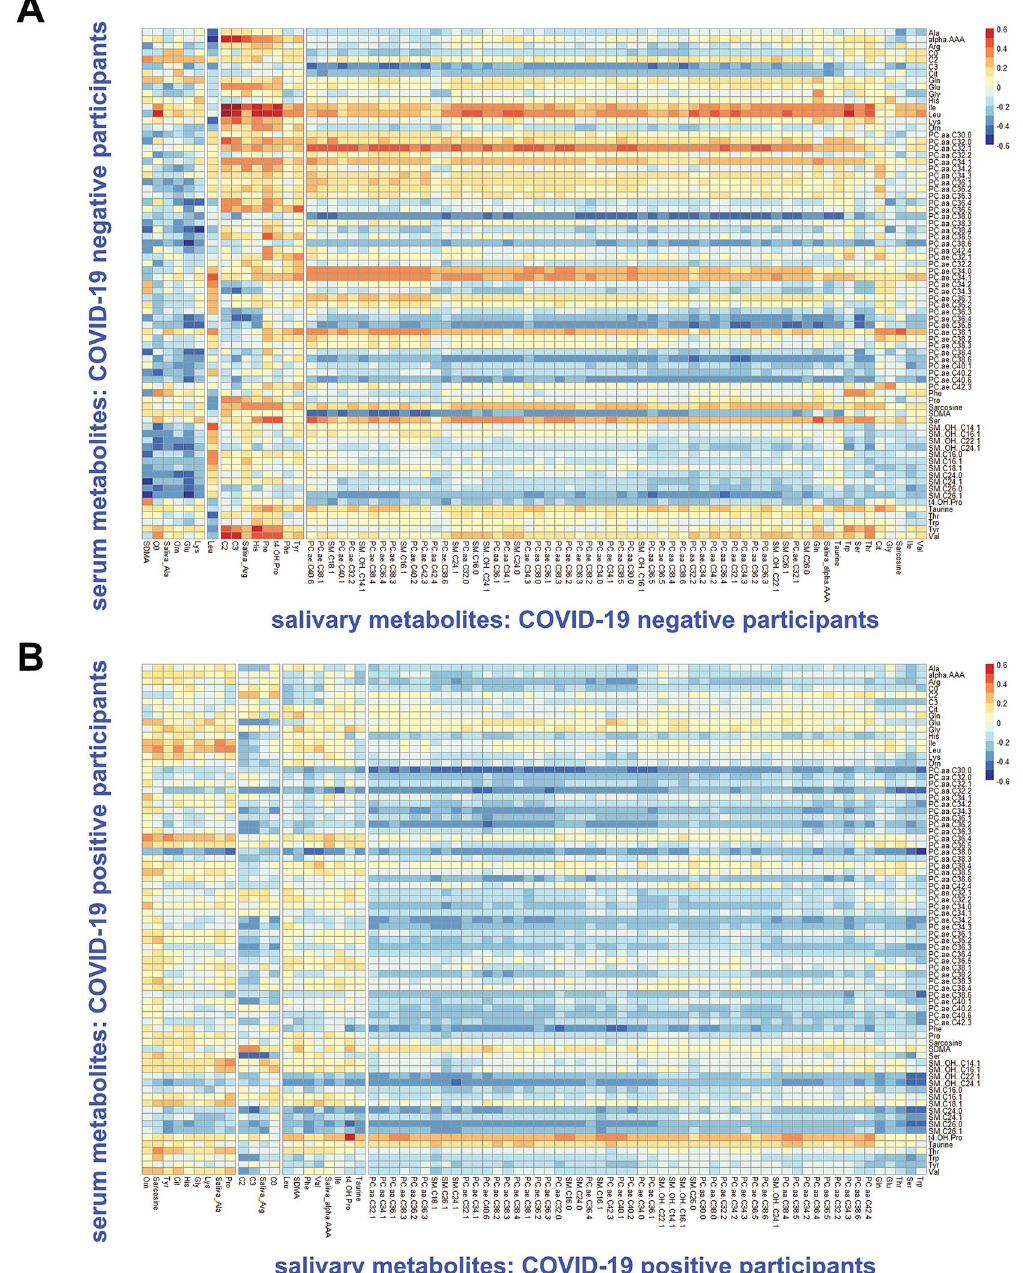
Figure 4. Heatmaps showing Pearson correlation coefficients between serum and salivary metabolites: sampled from study participants: COVID-19 negative participants ( A ) and COVID-19 positive participants ( B ).